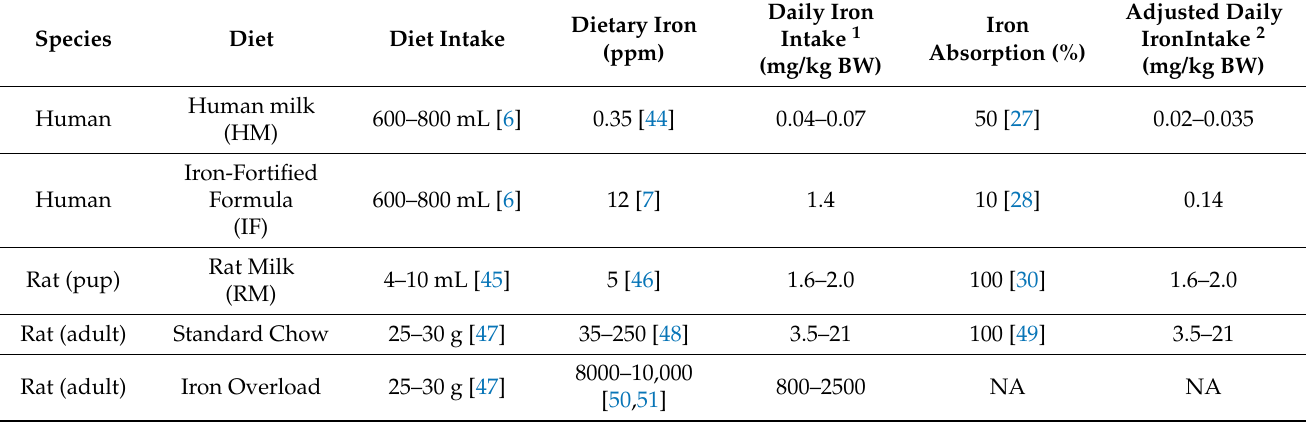
Table 1. The daily rat pup iron supplementation dose—10 mg elemental iron per kg body weight (BW)—was determined by estimating Adjusted Daily Iron Intakes of human milk (HM), iron-fortified formula (IF), and rat milk (RM) diets; these values were then used to calculate a daily supplemental iron intake for nursing rat pups that is proportional to the Adjusted Daily Iron Intake in infants fed exclusively IF relative to HM-fed infants (Equation (1)). Recommended iron intakes and experimental iron overload doses for adult rats are included for comparison and